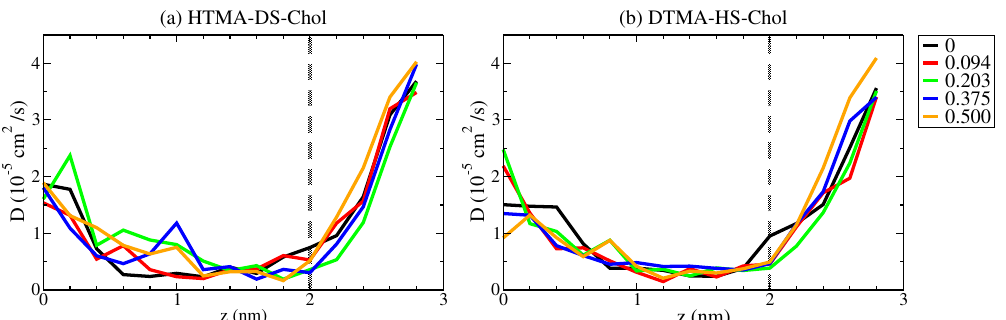
Figure 6. The local diffusivity profiles D ( z ) of the permeant water for ( a ) HTMA-DS-Chol and ( b ) DTMA-HS-Chol bilayers at various X chol .